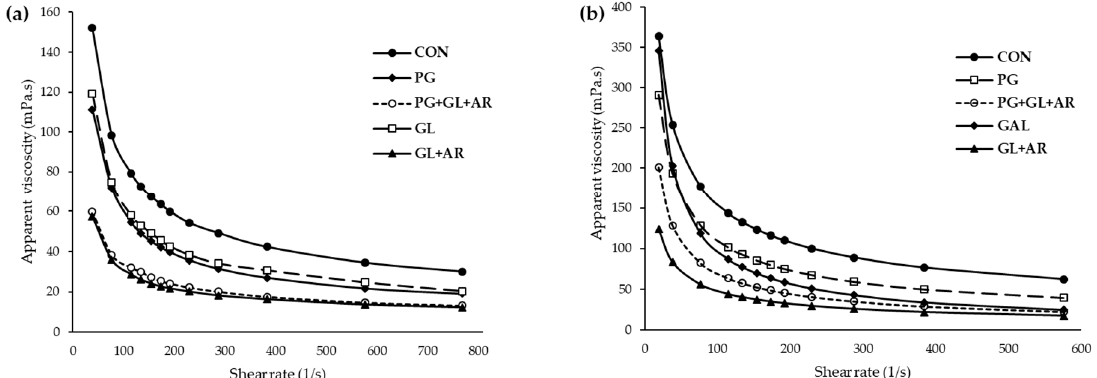
Figure 2. Apparent viscosity of OKP solutions ( a ) following enzymatic treatments and their corre- sponding emulsions and ( b ) at different shear rates.